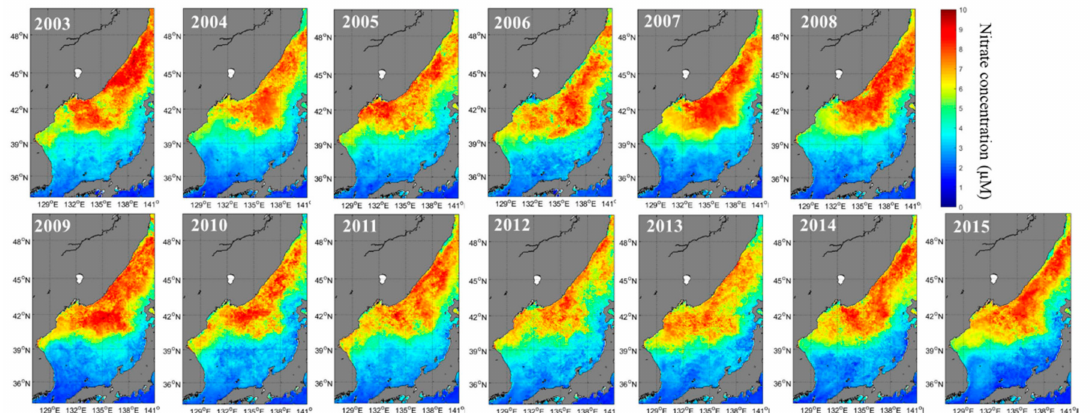
Figure 6. Long-term pattern of the annual Sea Surface Nitrate (SSN) in the East/Japan Sea (EJS) from 2003 to 2015.